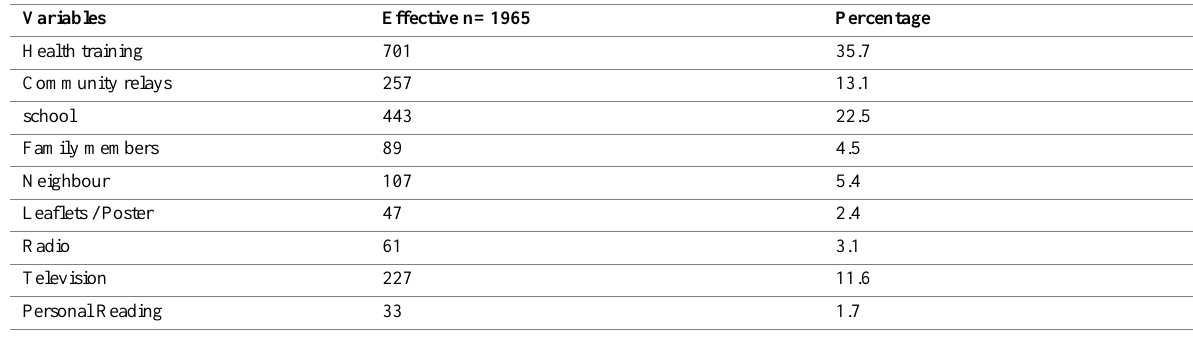
Table 2: Information Source on modern contraceptive methods.